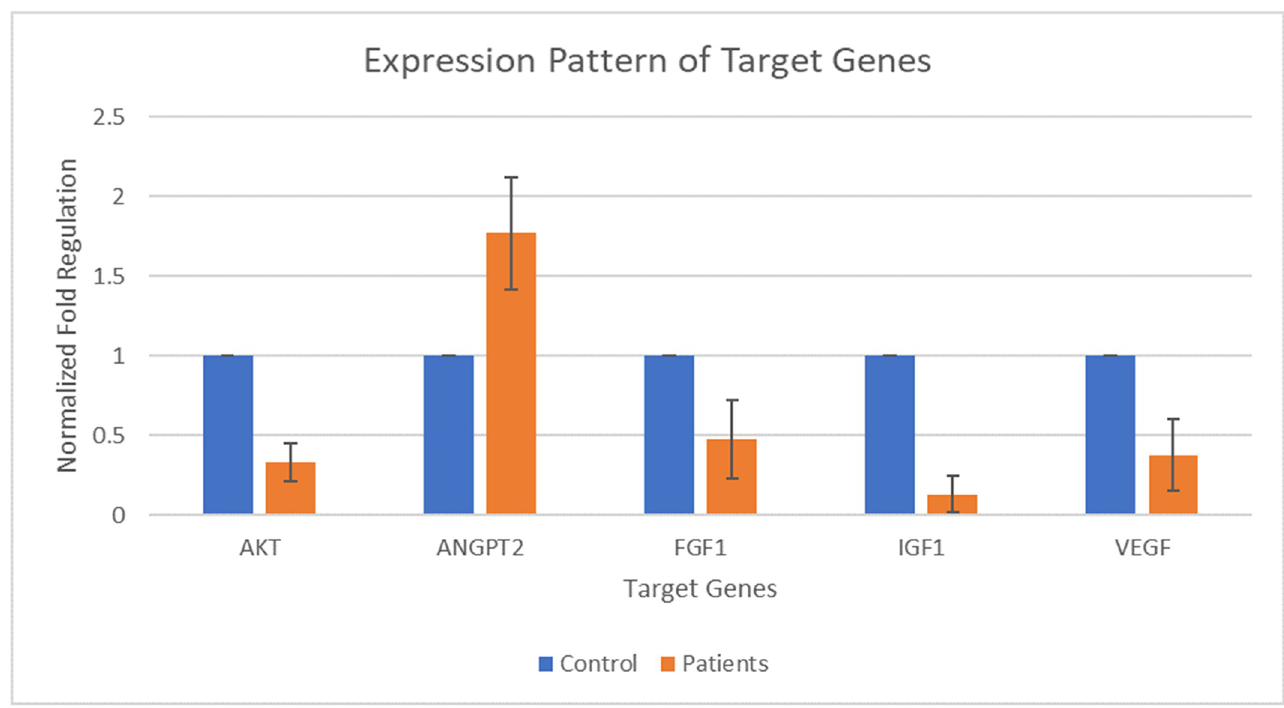
Fig 1. Expression pattern of AKT, ANGPT2, FGF1, IGF1, and VEGF during Type 2 diabetic cardiomyopathy. X-axis presenting the target genes along with control and patients’ group. Y-axis is presenting the fold increase or decrease in expression. Error bars indicating the standard deviation from the mean.